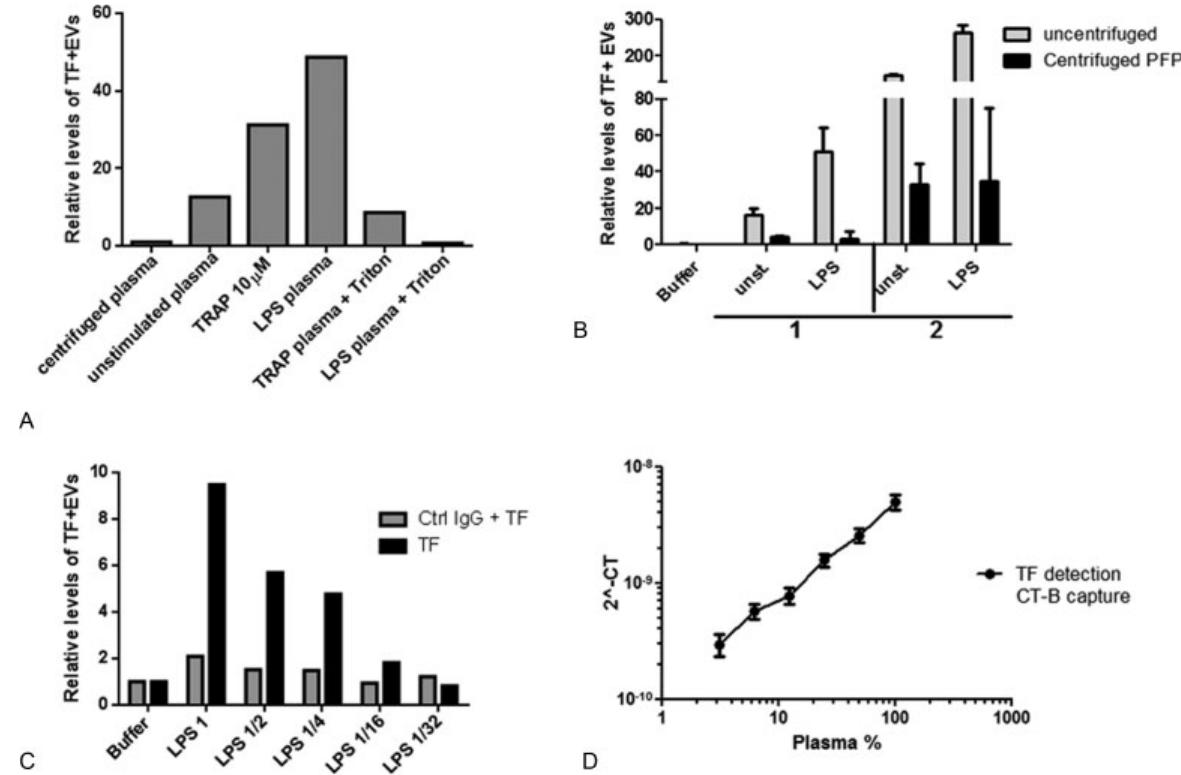
Fig.6 DetectionofTF þ EVsusingSP-PLAandCT-Bcapture.( A )ThelevelsofTF þ EVswasmeasuredwithSP-PLAbyusingCT-Bcaptureinunstimulatedplasma orinplasmafromTRAPorLPS-stimulatedwholebloodwithorwithouttriton-X100treatment.LevelsrelativetoEV-freeplasmaareshown.( B )ThelevelsofTF þ EVs weremeasured with SP-PLA inplasmasamples fromunstimulatedand stimulatedwholeblood fromtwoindividuals before (whitebars) andafter(black bars)centrifugationat20.000 (cid:2) g for60minutes.Levelsrelativetobufferaloneareshown.Errorbarsrepresentstandarddeviationfromtechnicalreplicates ( n ¼ 2).( C )LevelsofTF þ EVsweremeasuredbySP-PLAusingtheTFpolyclonalgoatantibodyconjugatedtobothPLAprobesasusual(blackbars)orbyusing theTFpolyclonalgoatIgG(conjugatedto probe1)together withacontrolgoatIgG(conjugatedtoprobe2)(gray bars).Thelevelsrelativetosignalinbuffer aloneisshown.( D )LevelsofTF þ EVsweremeasuredwithSP-PLAusingCT-BcaptureinplasmafromLPS-stimulatedwholeblood,diluted1:2inadilutionseries. The plasma concentration is plotted against linearized CT values. Error bars represent standard deviation of technical replicates ( n ¼